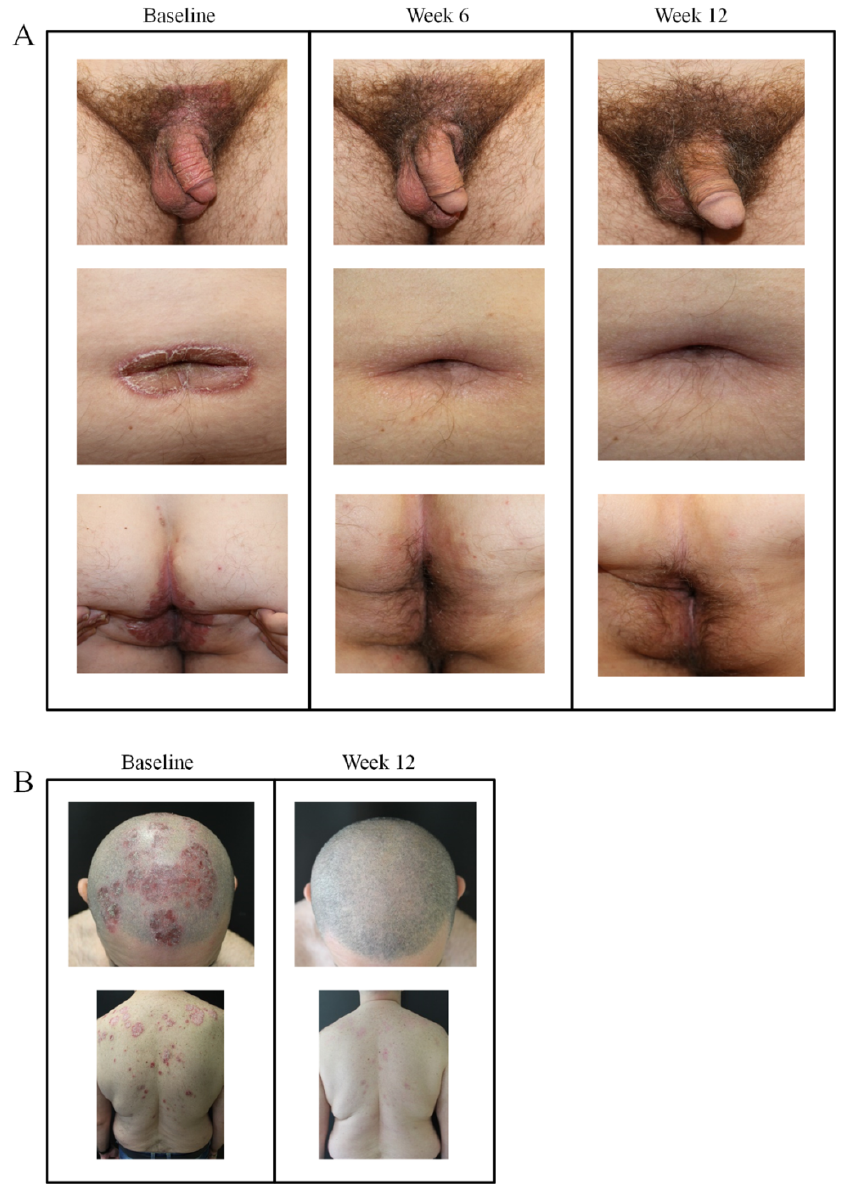
Figure 6. Plaque psoriasis in difficult-to-treat locations before and after initiation of guselkumab therapy. ( A ) Patient with psoriasis at genital (suprapubic area, penis foreskin perianal) and umbilicus/periumbilical areas at baseline and after 6 and 12 weeks of treatment. ( B ) Patient with head, scalp, and shoulder plaques prior to initiating guselkumab and after 12 weeks of therapy.